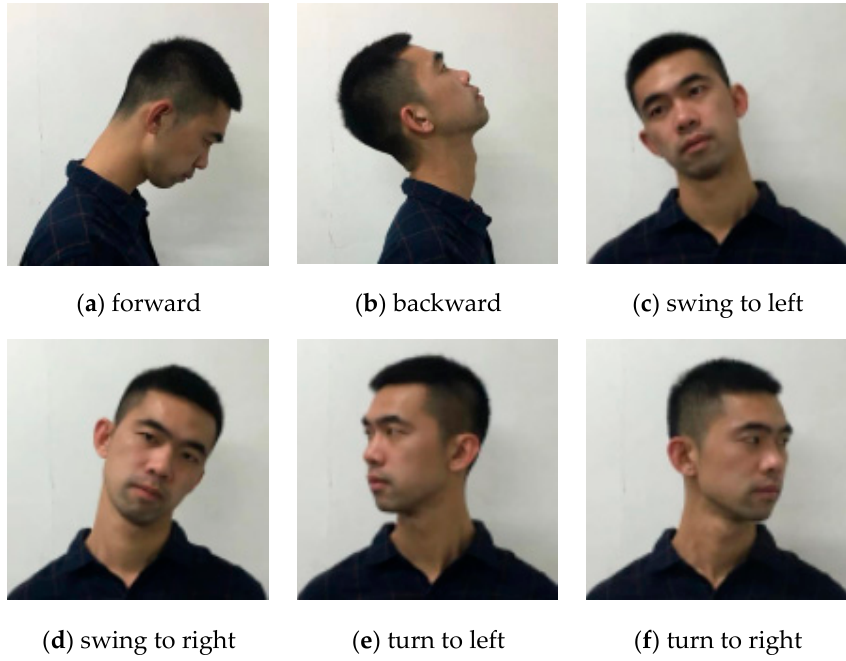
Figure 1. Six types of head motions.